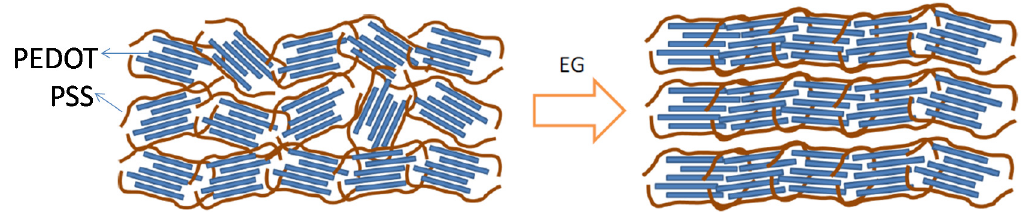
Figure 2. Morphological change in the PEDOT:PSS films caused by the addition of ethylene glycol (EG). Reproduced with permission from [22]. Copyright 2013 Wiley − VCH Verlag GmbH &